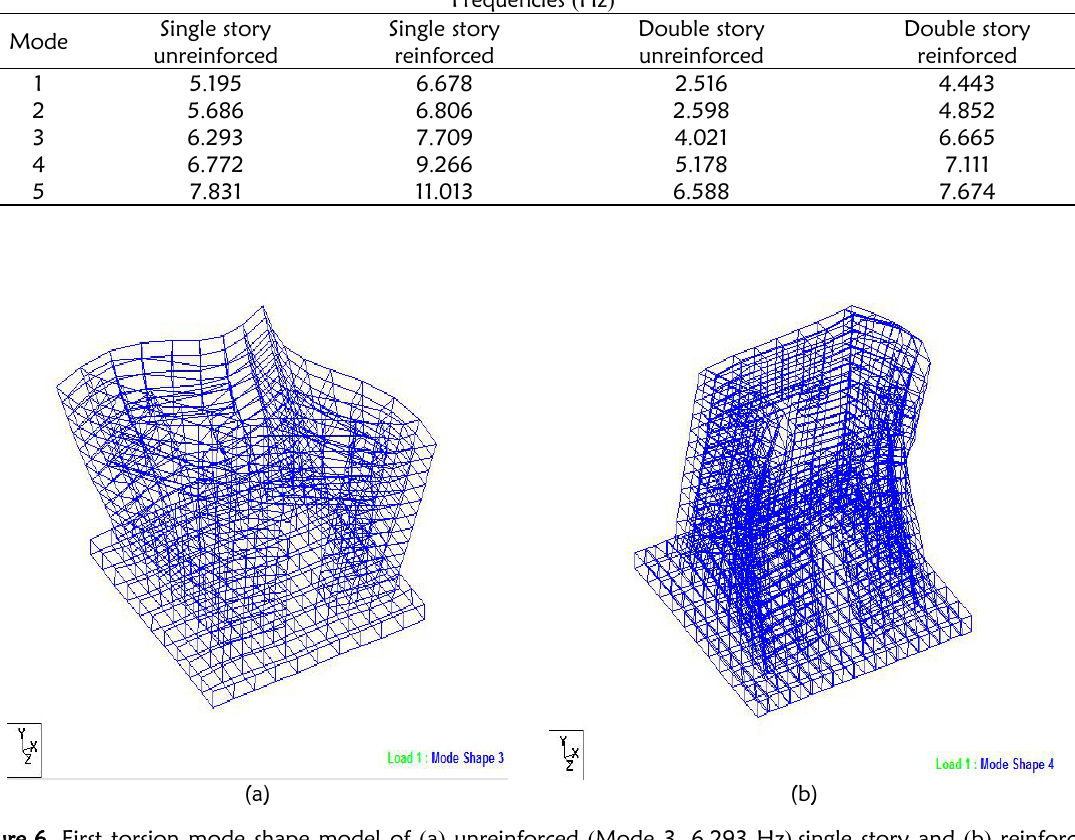
Figure 6 . First torsion mode shape model of ( a ) unreinforced ( Mode 3, 6 . 293 Hz ) single story and ( b ) reinforced single story ( Mode 4, 9 . 166 Hz